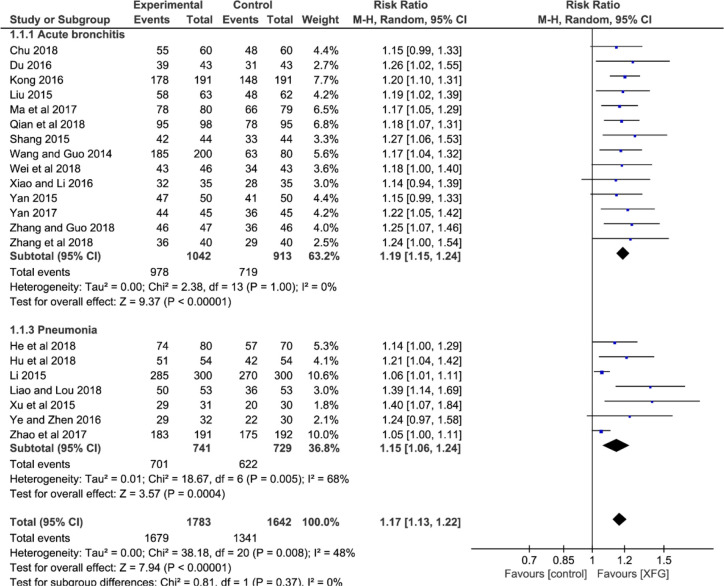
Forest plot and subgroup analysis of the CER.